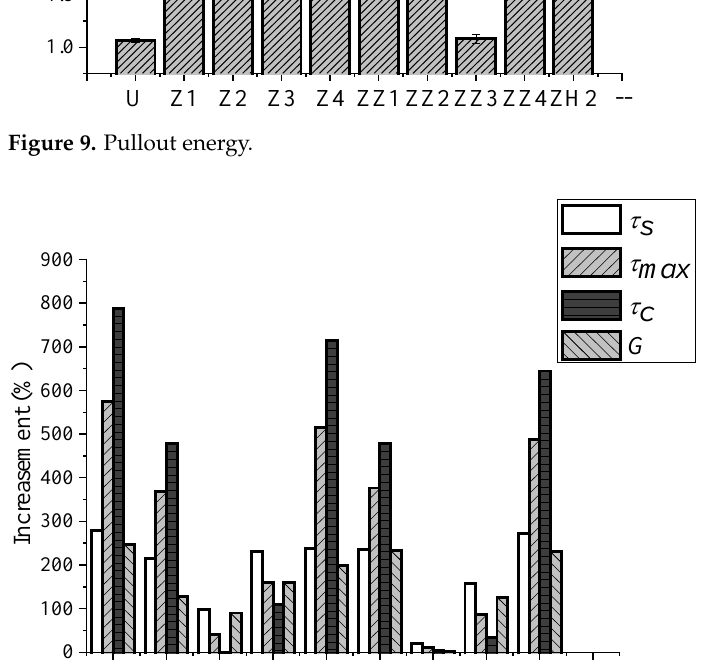
Figure 10. Increases of interfacial bonding strengths and pullout energy due to silane coatings.